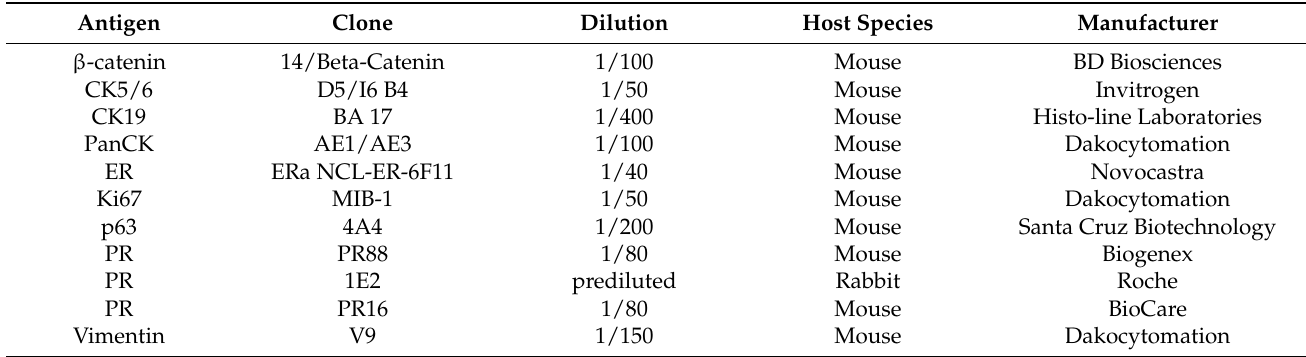
Table 1. Antibody panel for